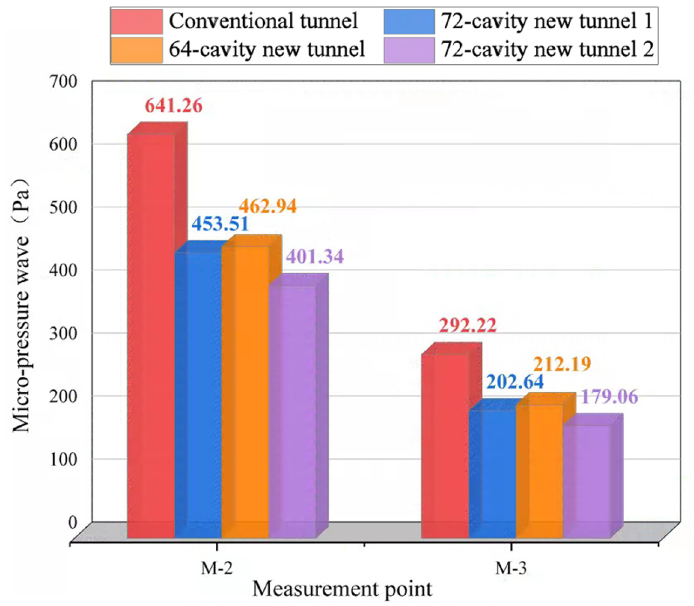
Figure 15. Effect of different layout options on micro-pressure waves.